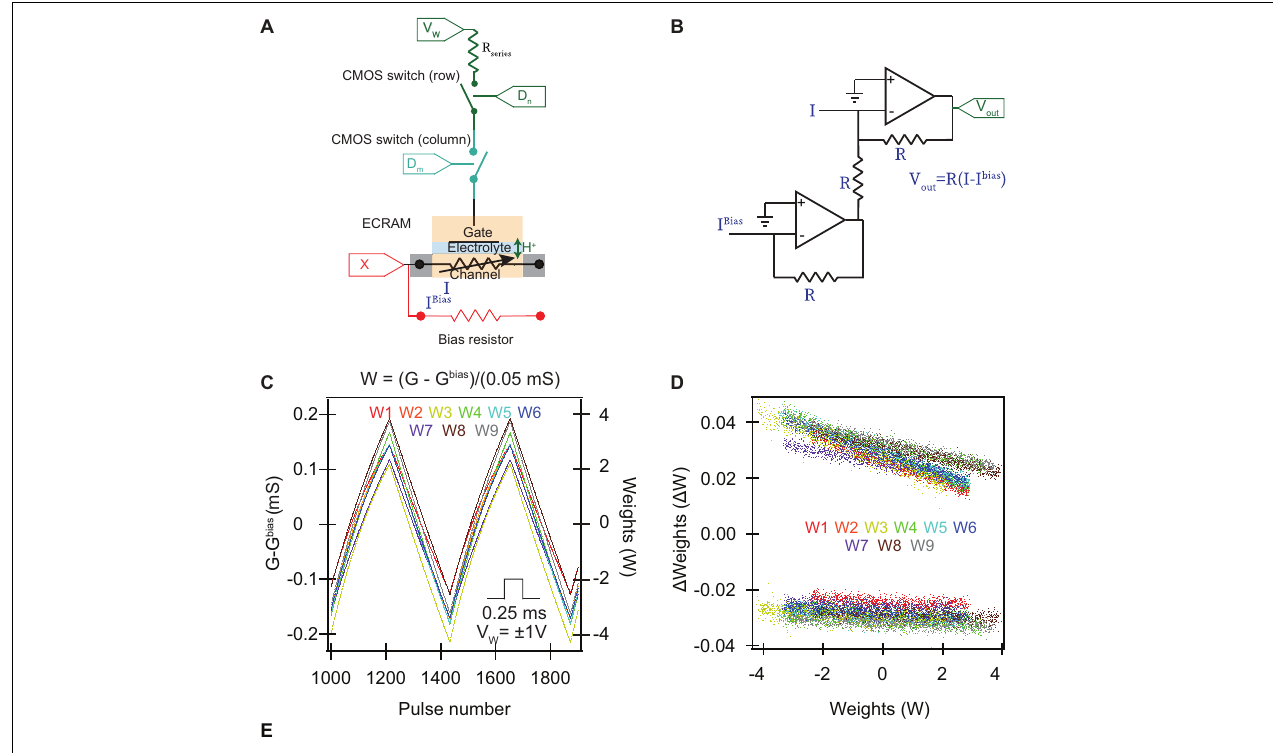
FIGURE 1 | Organic ECRAM cells as electrochemical synapses. (A) Each synapse in the crossbar array contains one ECRAM, a discrete bias resistor used to obtain negative weights, a series resistor to control the gate current, and two CMOS switches as selectors. The ECRAM cells store synaptic weights by electrochemical doping/de-doping of the channel, which alters its electronic conductivity. When both switches are ON, the write current programs the redox transistor to the desired state. When either or both switches are OFF, the ECRAM cells retain their state. Two switches are used to accommodate the outer product update. (B) Subtractor circuit used to calculate the difference in the conductance between the ECRAM channel and the bias resistor; the same circuit is used when the currents from multiple devices are summed in an array. 10 k (cid:127) resistors were used for R series in (A) and all resistors in (B) . (C) Potentiation and depression of nine synapses, using pulses of identical magnitude. The resulting current (positive or negative) is used to calculate G bias i is the conductance of the bias resistor, as written in (E) . The non-dimensional weight is computed during post-processing by W i = (D) Device-to-device variation of the nine synapses, showing the weight update for different starting weight values. Each device completed 50 full cycles, where each cycle equals 440 weight updates, equally divided amongst potentiation and depression. For clarity, a random 10% subset of the ∼ 20,000 weight updates for each device are shown. (E) The conductance values of the fixed discrete bias